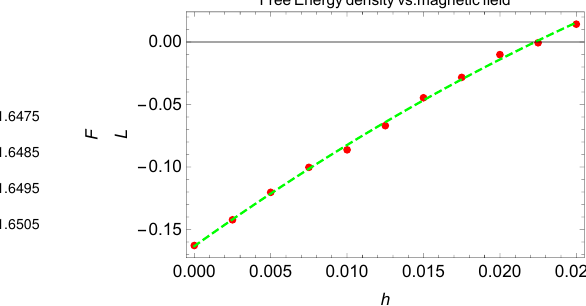
x; u ) (cid:0) a 0 (0 ; u ) vs. b